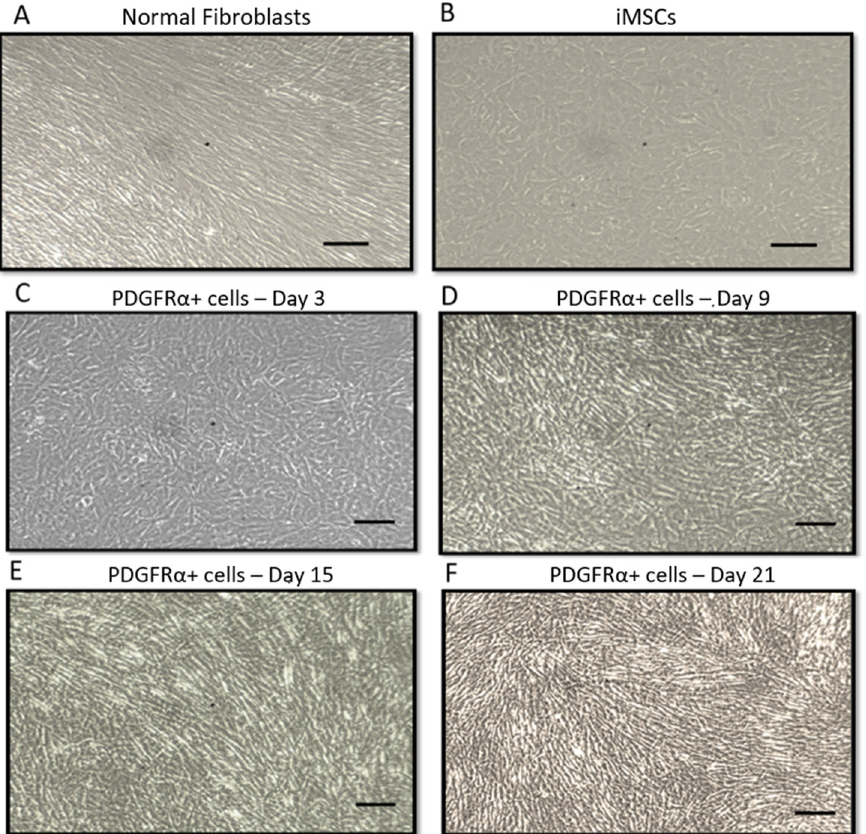
Figure 1. Morphological changes associated with differentiation of immortalized human bone marrow derived mesenchymal stromal cells (iMSCs) into platelet-derived growth factor receptor- α -positive cells (PDGFR α -positive cell) using contrast microscopy. Representative microscope images showing the morphological features of ( A ). Normal fibroblasts. ( B ). Morphological features of iMSCs cells prior to the differentiation process. ( C – F ). Differentiation of iMSCs into PDGFR α -positive cells as shown by Day 3, Day 9, Day 15, and Day 21, respectively ( n = 3, Scale bar = 10 nm).